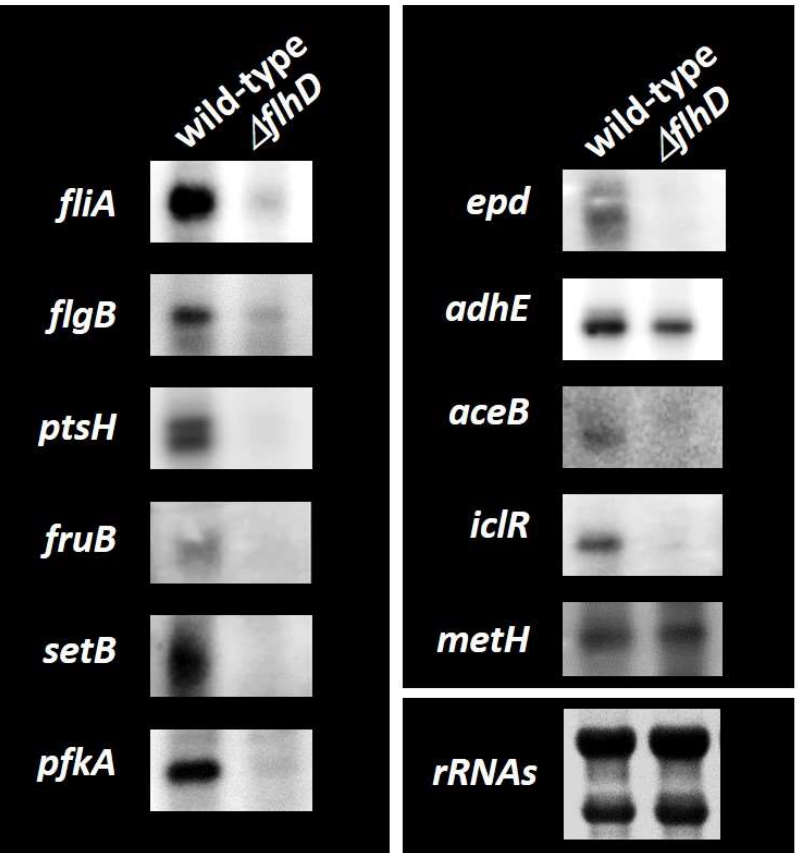
Figure 4. Northern blotting analysis of mRNAs from FlhDC target genes. Wild-type E. coli K-12 BW25113 and its flhD mutant JW1881 were grown in M9 0.2% glucose media. Total RNA was prepared during the exponential phase and subjected to Northern blotting analysis. DIG-labeled hybridization probes are shown on the left side of each panel. The amounts of total RNA analyzed were examined by measuring the intensity of ribosomal RNAs.